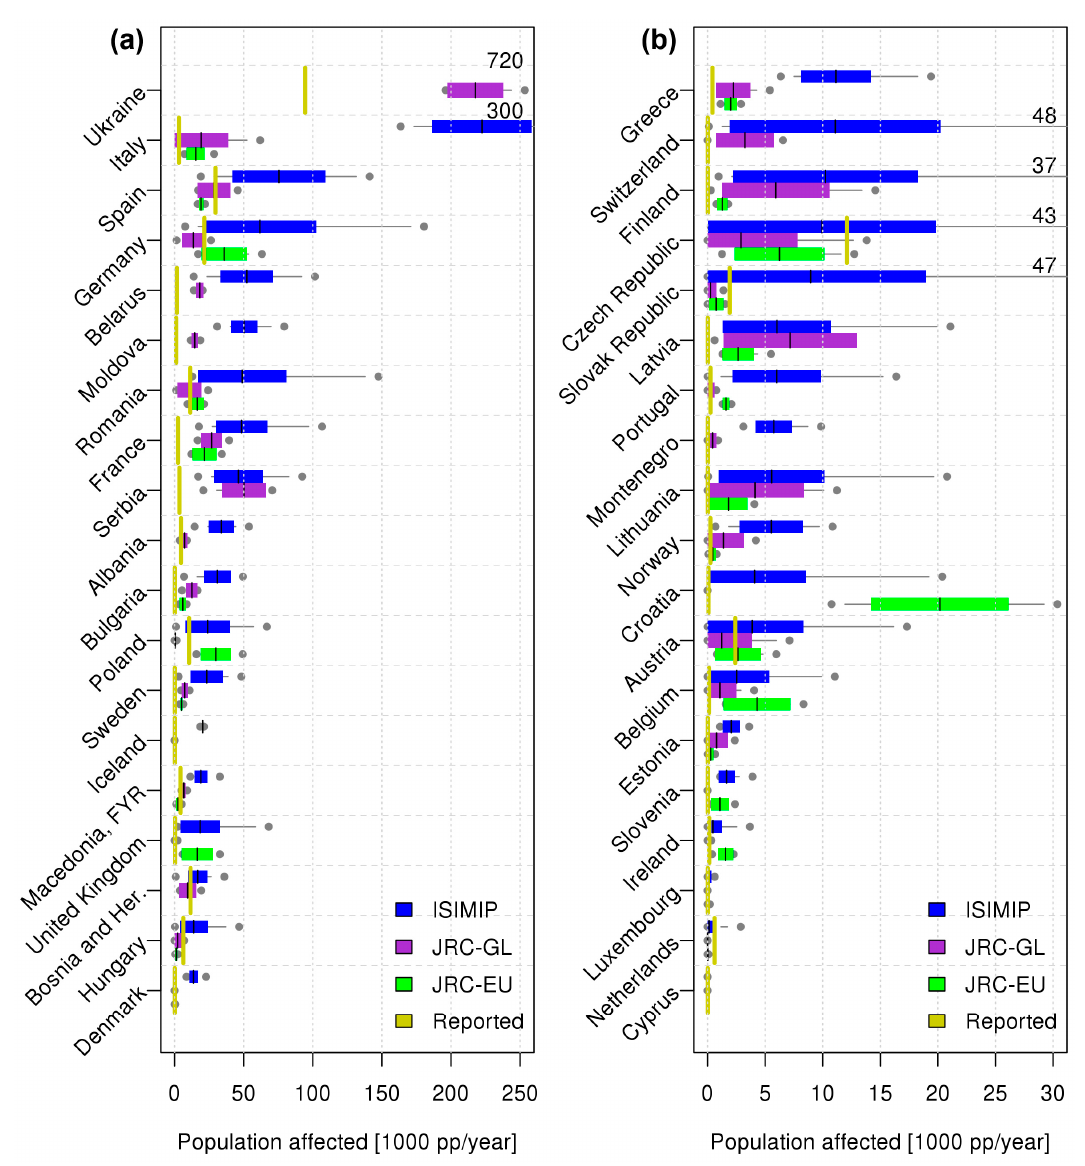
Figure 3. Population affected computed for the baseline period for each country by the ensembles of the three case studies ( a , b ). Plots show the average (black dash), ± 1 standard deviation (colored bar), and minimum and maximum values (whiskers) of each ensemble. In gold are shown impact values reported in the Emergency Events Database (EM-DAT).